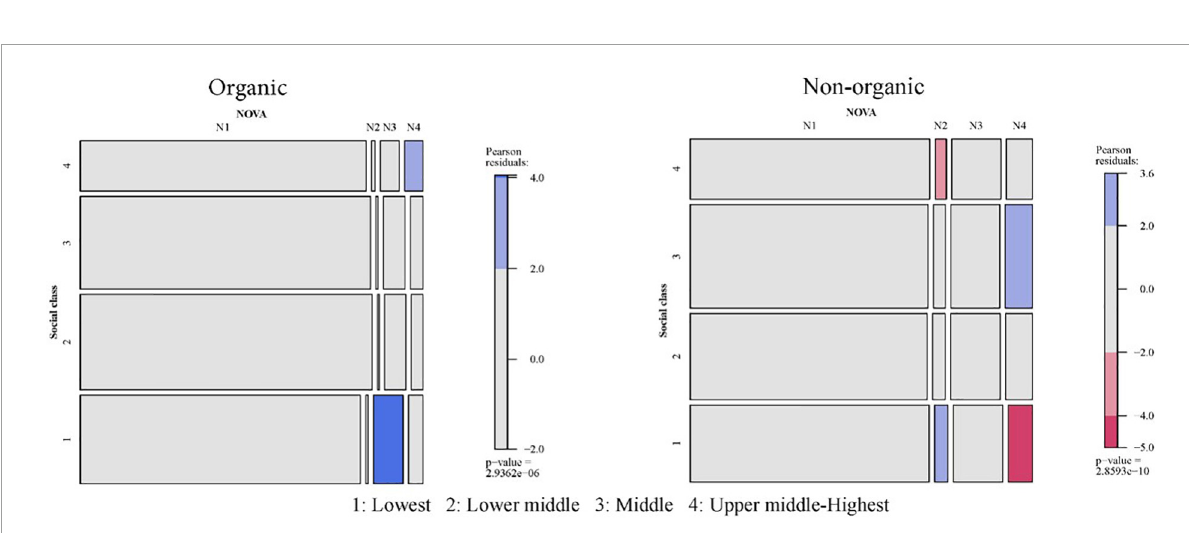
FIGURE3 Relationship between social class by incomes and NOVA: Organic vs. non-organic food purchases. 1: Lowest; 2: Lower middle; 3: Middle; 4: Upper